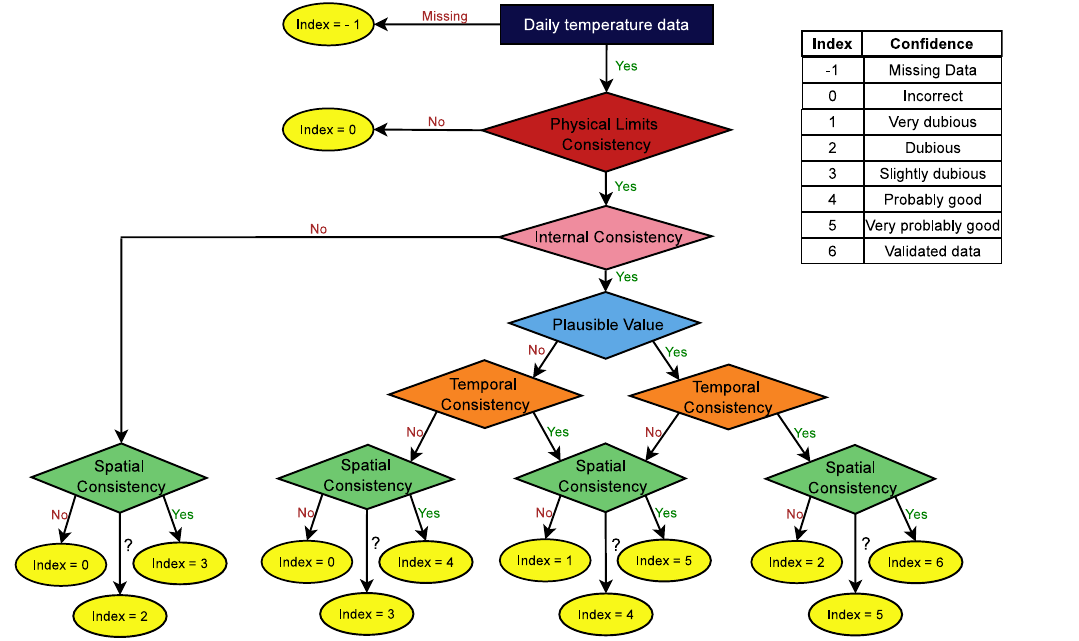
Figure 3. Automated QC applied to temperature records and associated confidence index.